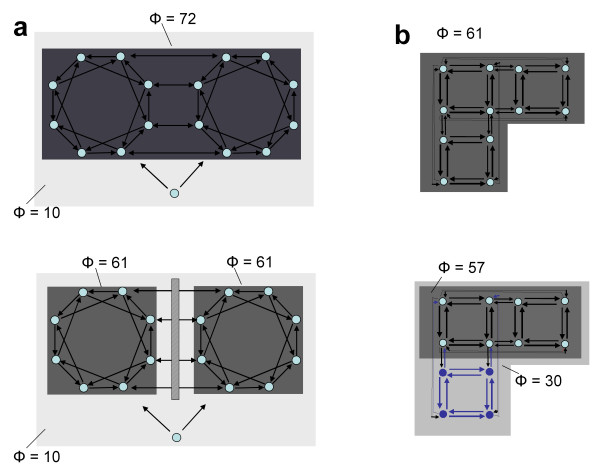
Information integration and complexes after anatomical and functional disconnections. a. Schematic of a split-brain-like anatomical disconnection. Top. Shown is a large main complex obtained by connecting two thalamocortical-like subsets through "callosum-like" reciprocal connections. There is also a single element that projects to all other elements, representing "subcortical" common input. Note that the Φ value for the main complex (16 elements) is high (Φ = 72 bits). There is also a larger complex including the "subcortical" element, but its Φ value is low (Φ = 10). Bottom. If the "callosum-like" connections are cut, one obtains two 8-element complexes, corresponding to the two "hemispheres", whose Φ value is reduced but still high (Φ = 61 bits). The two "hemispheres" still share some information due to common input from the "subcortical" element with which they form a large complex of low Φ. b. Schematic of a functional disconnection. Top. Shown is a large main complex obtained by linking with reciprocal connections a "supramodal" module of four elements (cornerstone) with a "visual" module (to its right) and an "auditory" module (below). Note that there are no direct connections between the "visual" and "auditory" modules. The 12 elements together form a main complex with Φ = 61 bits. Bottom. If the "auditory" module is functionally disconnected from the "supramodal" one by inactivating its four elements (indicated in blue), the main complex shrinks to include just the "supramodal" and "visual" modules. In this case, the Φ value is only minimally reduced (Φ = 57 bits).